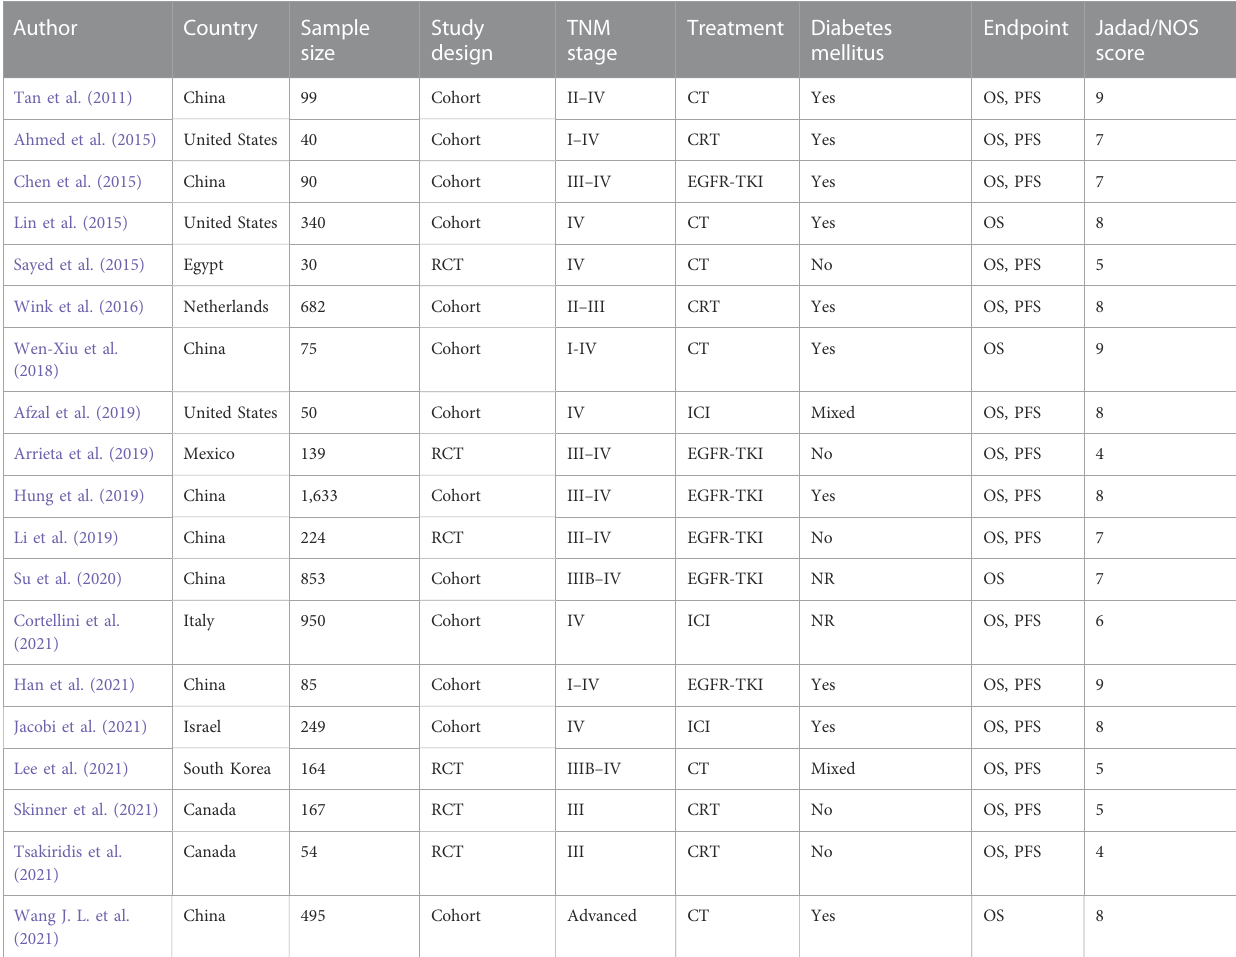
TABLE 1 Basic characteristics of included